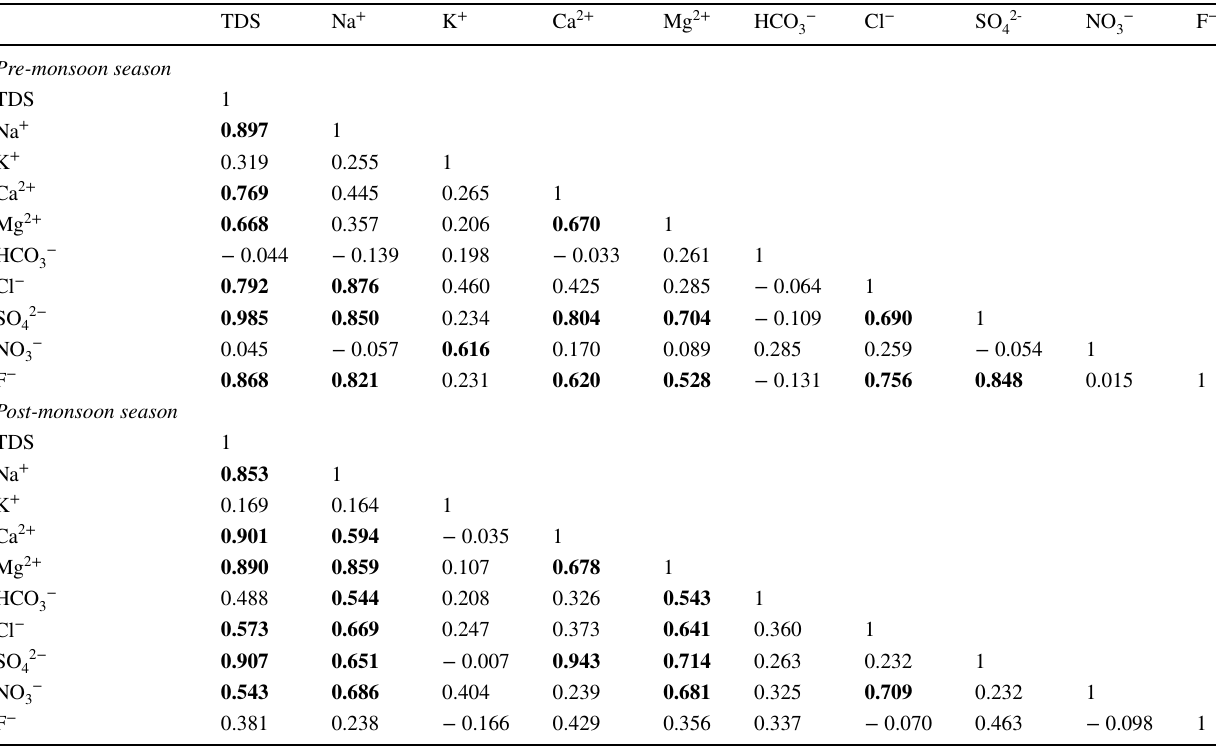
Bold values are indicate strong correlationcoefficient between chemical parameters at level of